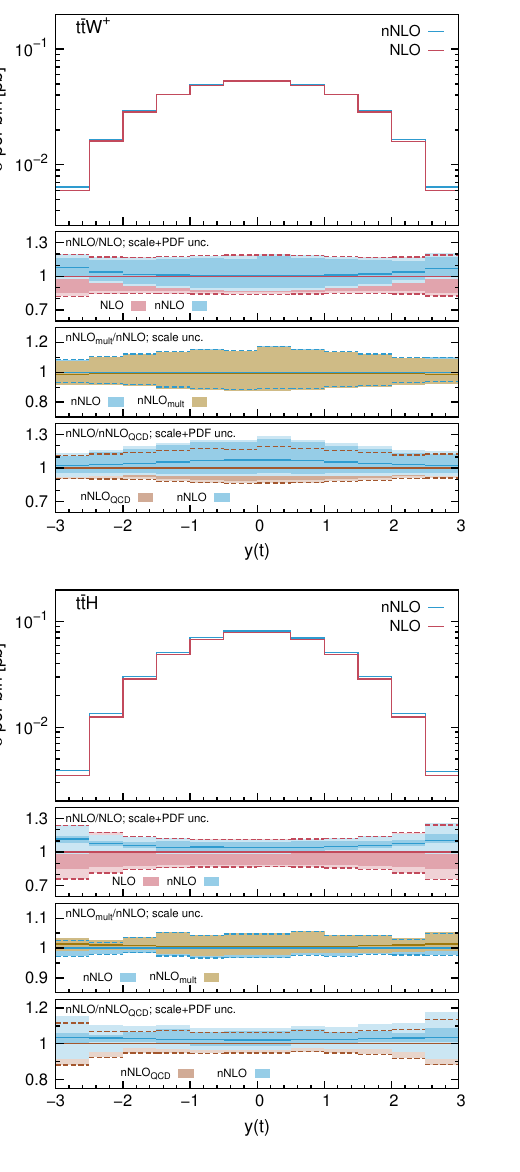
Figure 7 . Distributions di(cid:11)erential w.r.t. the top-quark rapidity. Same structure as in (cid:12)gure 2, but with the substitution NLO QCD +NNLL ! nNLO QCD , NLO+NNLL ! nNLO, and NLO (cid:2) NNLL ! nNLO mult .